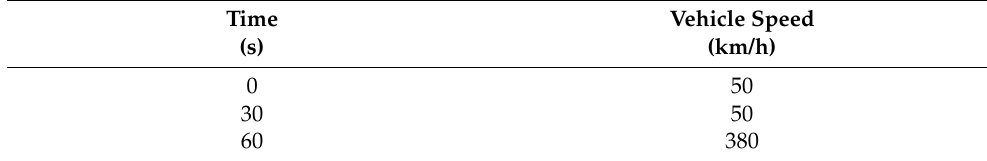
Figure 18. Comparison between TEST (without calibration) and PROPS total torques during the execution of the calibra- tion speed profile.